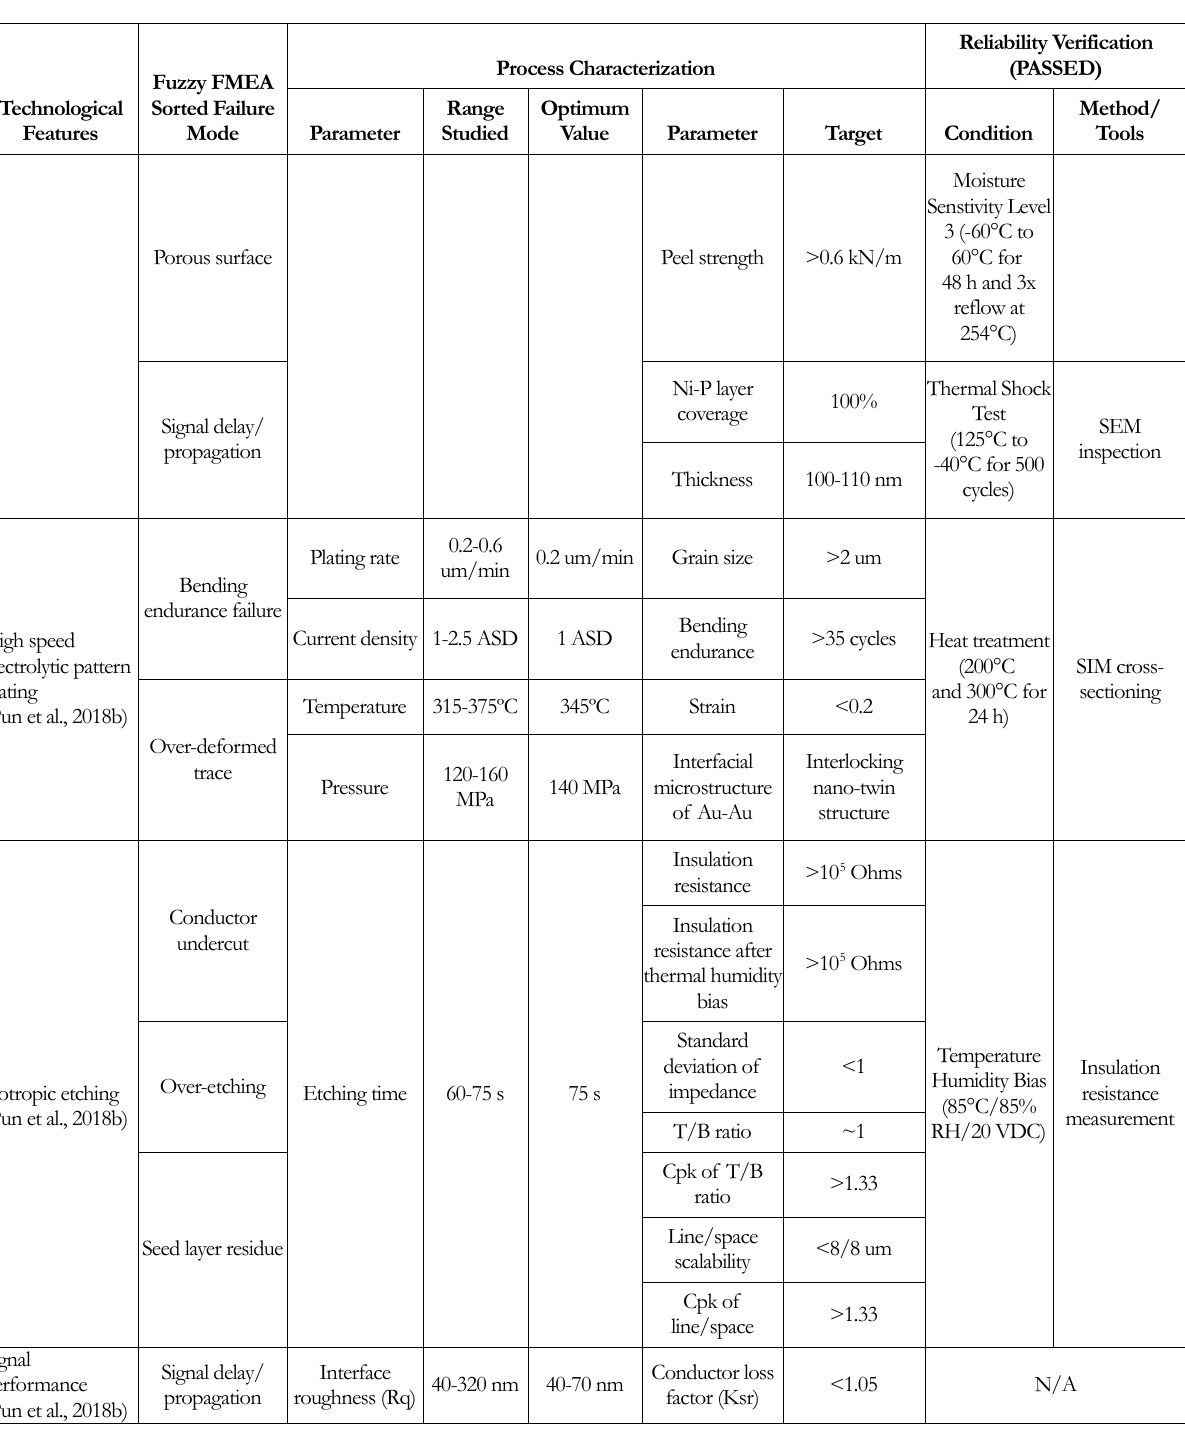
Table 5. Critical parameter optimization based on the critical quality attribute